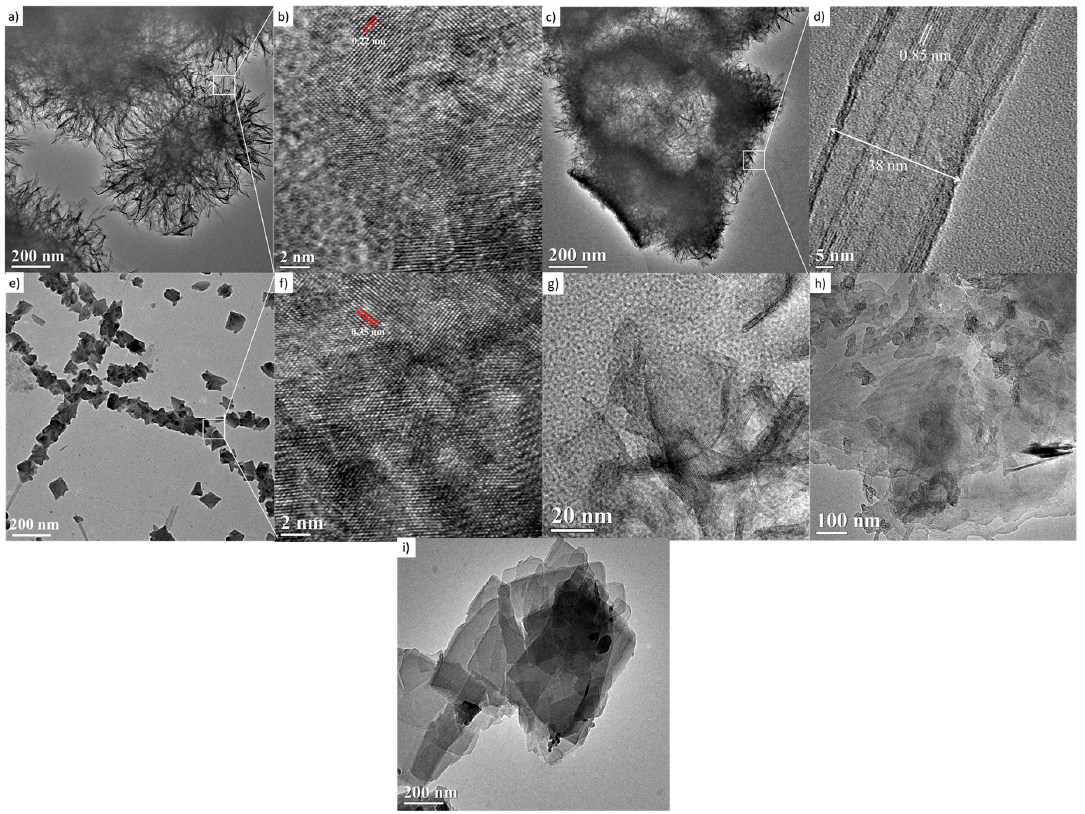
Figure 7. HRTEM images of the samples treated hydrothermally at 110 °C for 24 h. ( a , b ) 1 M; ( c , d ) 2 M; ( e , f ) 3 M; ( g ) 5 M; ( h ) 9 M; and ( i ) 10 M.